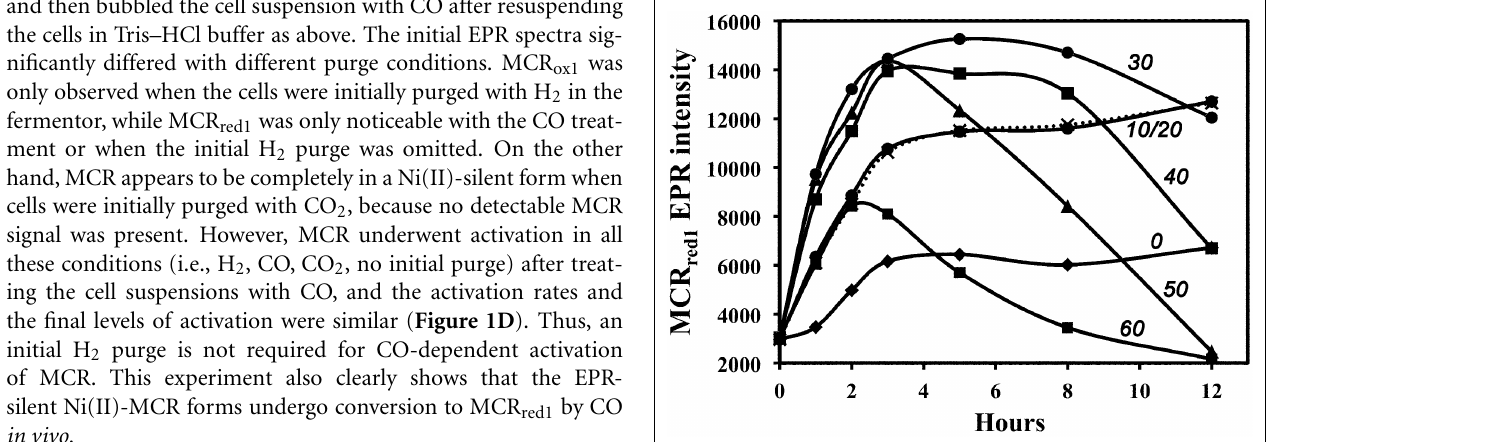
FIGURE 2 |Temperature dependence of in vivo MCR activation in whole cells by CO. Activation temperatures ( ◦ C) are shown beside the relevant line.